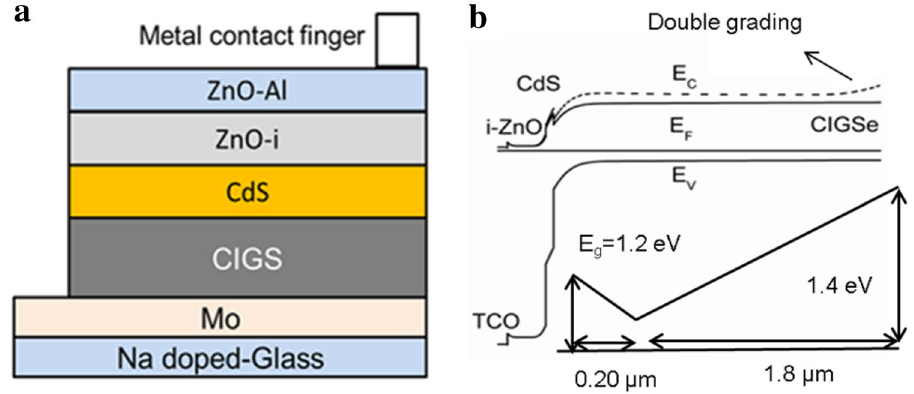
Fig. 2 a Device structure and its corresponding energy-band diagram at equilibrium and b straight line—no grading, dotted—double grading, inset— schematic of the “notch-type’ gallium distribution in CIGSe device, axis scale—CIGSe layer thickness vs.